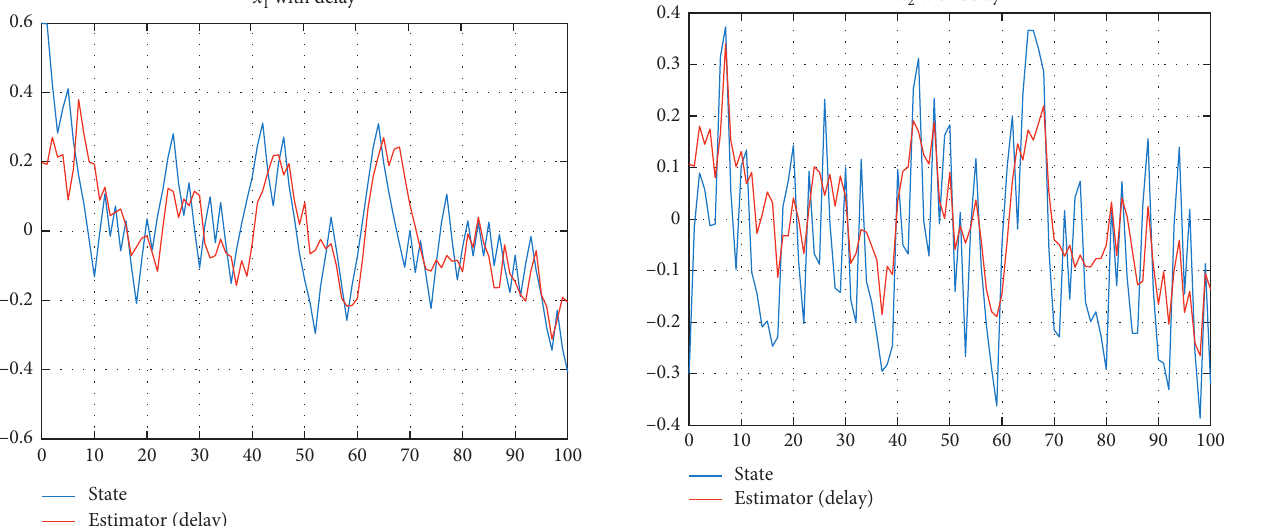
( k ) and the filter 􏽢 x ( k | k ) 2